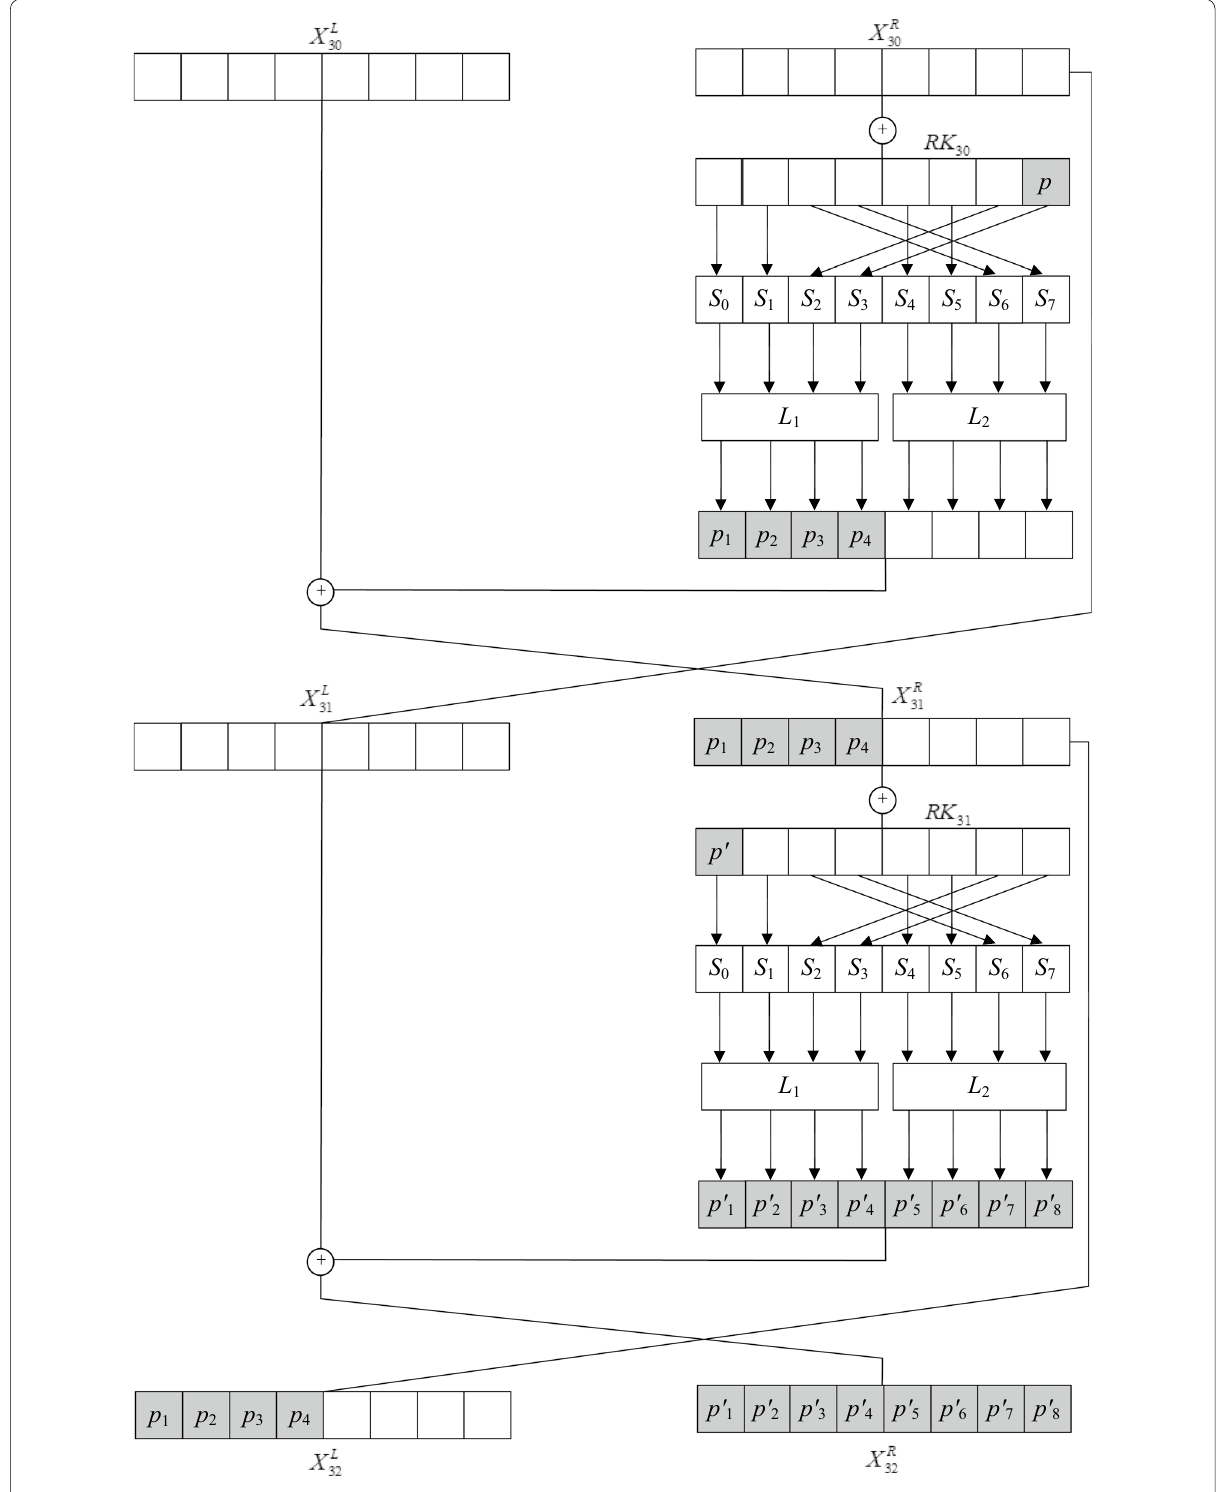
Fig. 5 The fault propagation process on RK 7